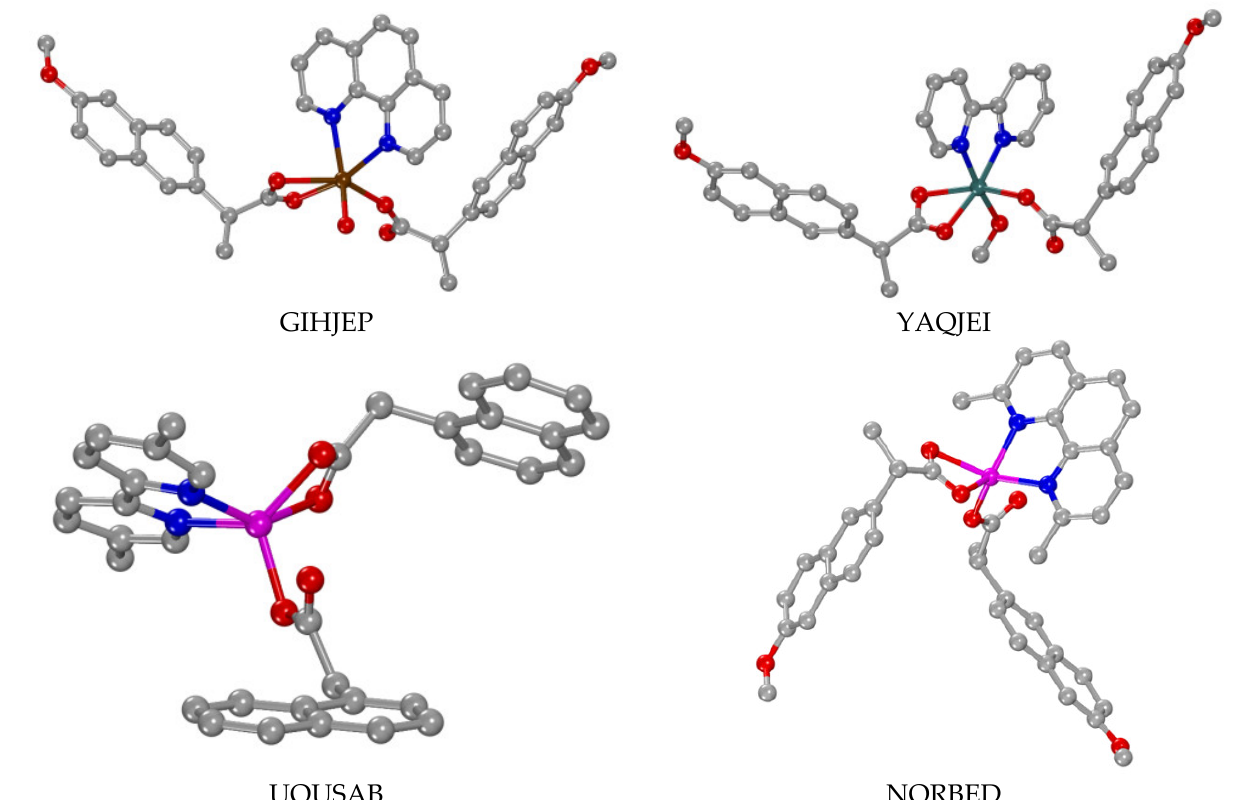
Figure 17. Molecular structures of selected complexes bearing monodentate and bidentate chelating ligands. GIHJEP = [Mn(NAP–O)(NAP–O,O′)(phen)(H 2 O)] [42]; YAQJEI = [Ni(NAP–O)(NAP–O,O′)(bipy)(H 2 O)] [61]; UQUSAB = [Zn(N1A–O)(N1A–O,O′)(5,5′–Me 2 –bipy)] [64] and NORBED = [Zn(NAP–O,O′) 2 (neoc)] [63]. Hydrogen atoms, disordered atoms and solvate molecules are omitted for clarity reasons. Color code for atoms: C: gray, O: red, N: blue, Mn: brown, Zn: magenta and Ni: petrol green. The figures of the structures were adapted from the corresponding references.